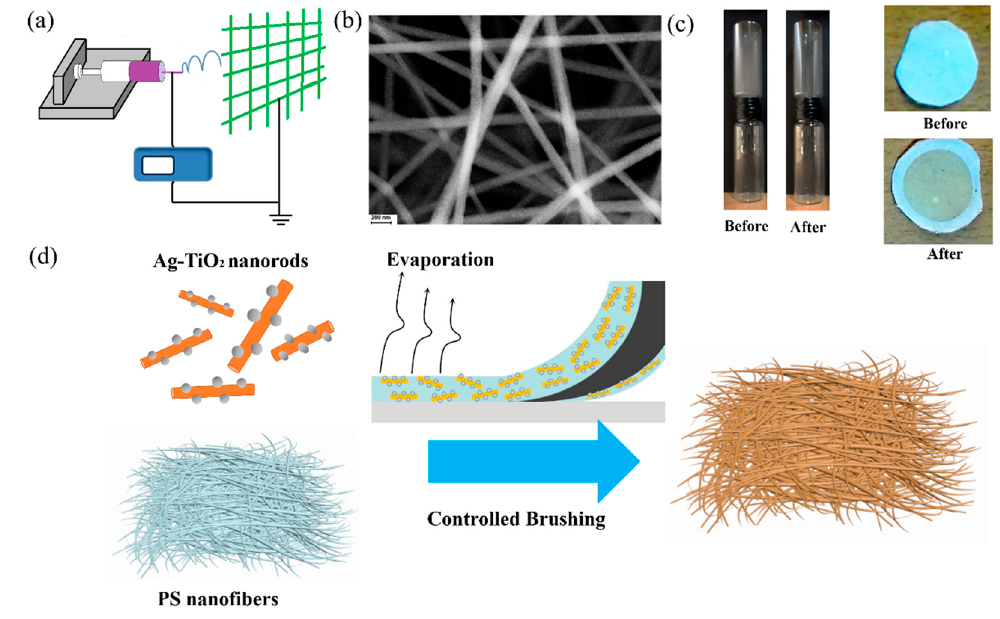
Figure 4. ( a ) A scheme of the process of electrospinning and ( b ) an SEM image of polystyrene (PS) nanofibers. ( c ) An experiment on the adsorption of PM conducted by using PS nanofibers. ( d ) The process of the fabrication of Ag-TiO2 nanorod composite-loaded PS nanofibers.